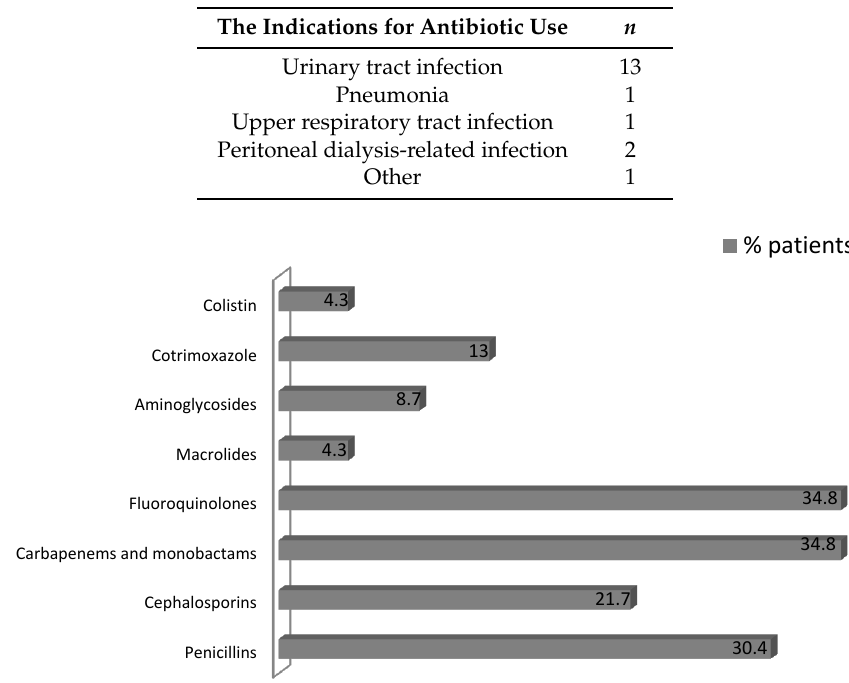
Figure 2. The antibiotic exposure in the CDI patients.